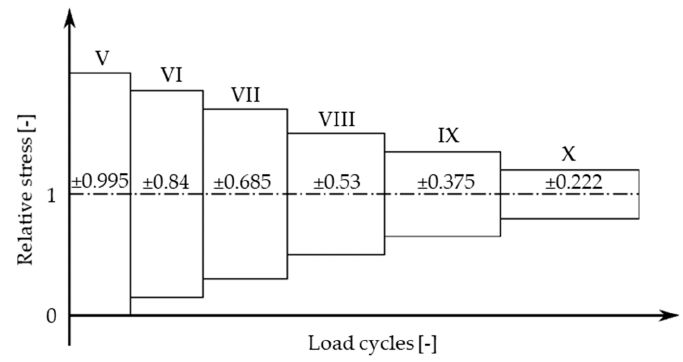
Figure 15 . Simplified load spectrum based on TWIST [10]. Table 6. Fatigue data for each load block for the simplified load spectrum based on TWIST [10].